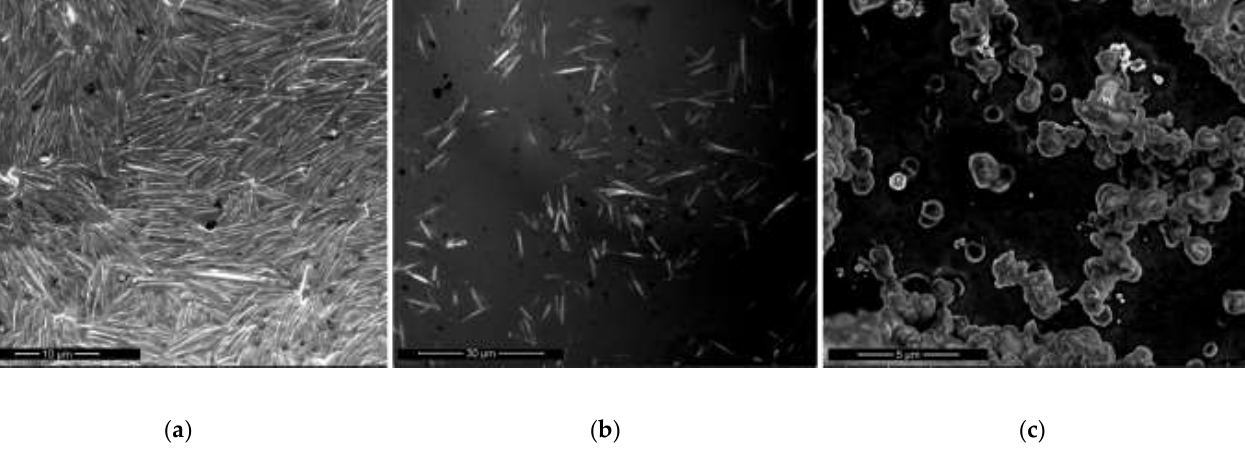
Figure 1. SEM images of copper nanowires with: ( a ) 15 µL; ( b ) 30 µL; ( c ) 240 µL of N 2 H 4.